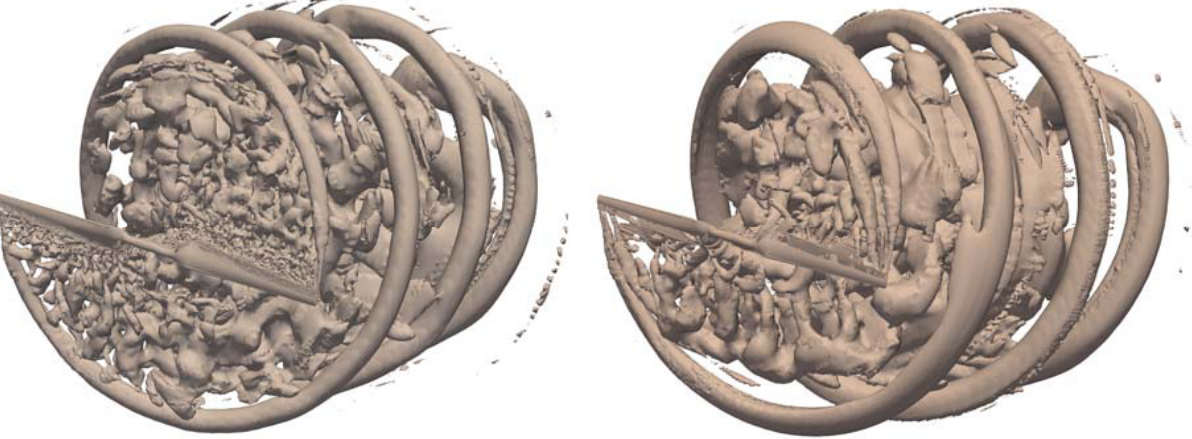
Figure 15. Lambda2 criterion when wind speed = 10 m/s and time = 1.4 s ( left : VLES; right : URANS).